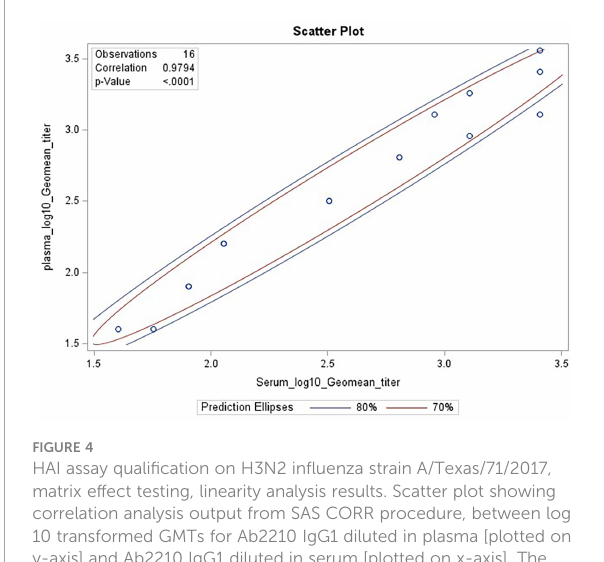
FIGURE 3 HAI assay quali fi cation on H3N2 in fl uenza strain A/Texas/71/2017, system suitability criteria results. Geometric mean titers [GMTs] for positive control Ab2210 IgG1 and negative control 7B2 IgG1 from all experiments. Nineteen data points plotted for both controls. Titers of<20 or<10 are converted to half of the lowest dilution tested in assay, in this case 10 or 5, respectively, to enable statistical analysis. The Ab2210 IgG1 titers are illustrated with red dots, the 7B2 titers are illustrated with orange dots. The dotted line indicates a GMT of 20.